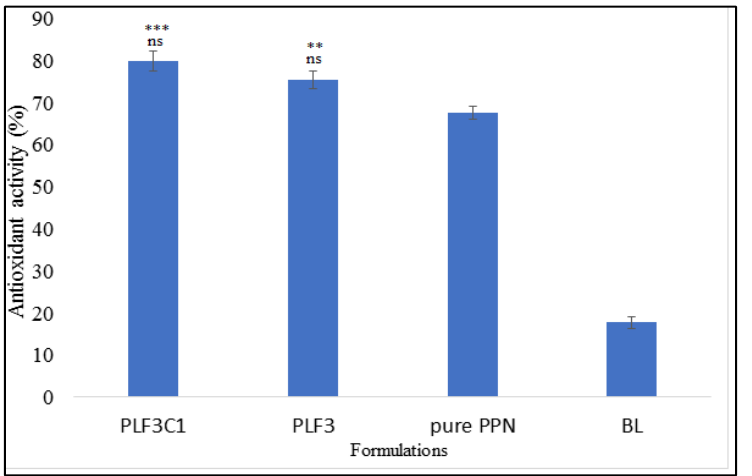
Figure 5. Antioxidant activity of the tested samples using the DPPH method. The Tukey–Kramer multiple comparison test was utilized to analyze the statistically significant difference between each group. Difference was considered significant if p < 0.05. ns = not significant when compared between PPN liposomes (PLF3) and chitosan-coated PPN liposomes (PLF3C1); *** = p < 0.001 when compared with pure PPN; ** = p < 0.01 when compared with pure